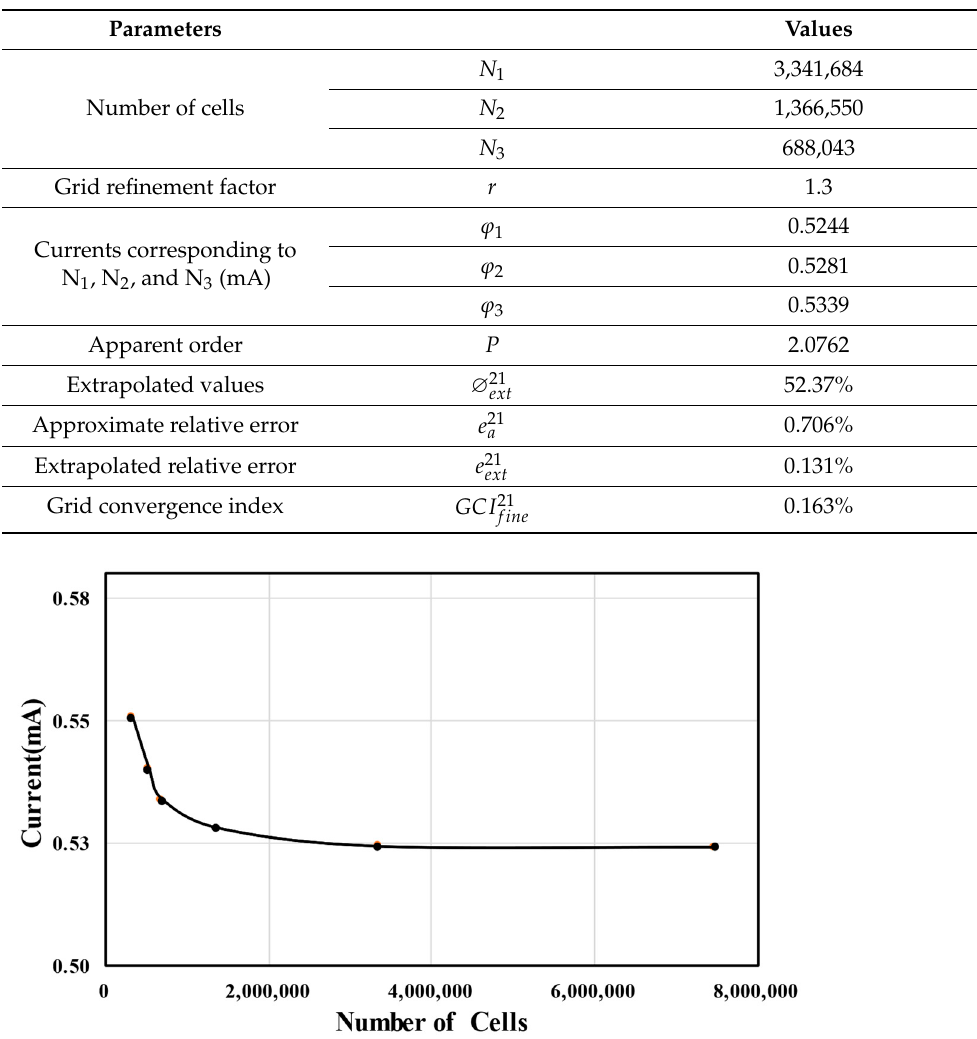
Table 1. Grid convergence index (GCI) analysis for the MMFC current.